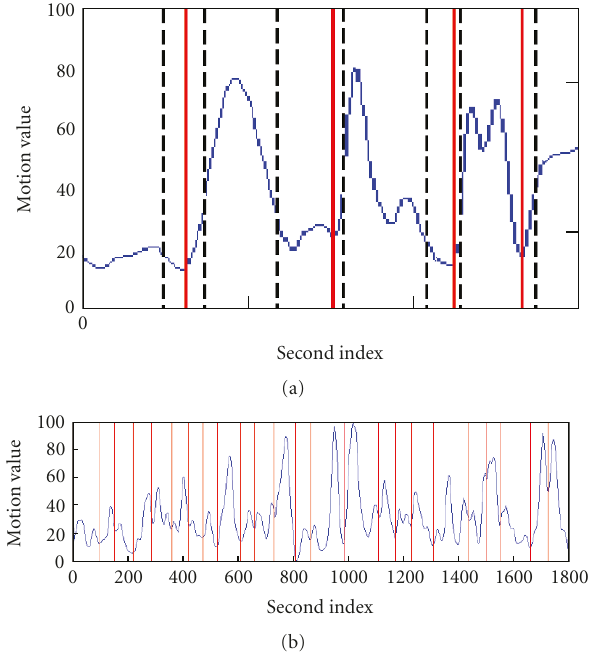
Figure 3: (a) An example result of the modified change point detection (solid line) compared to that of the original one (dash line), (b) event segmentation using change point detection under a homoscedastic error